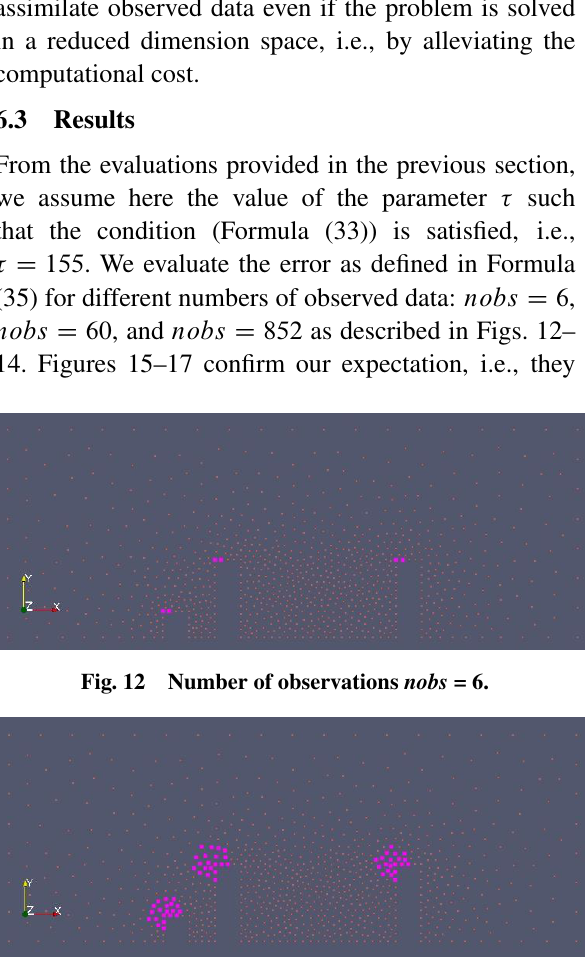
Fig. 13 Number of observations nobs =60.